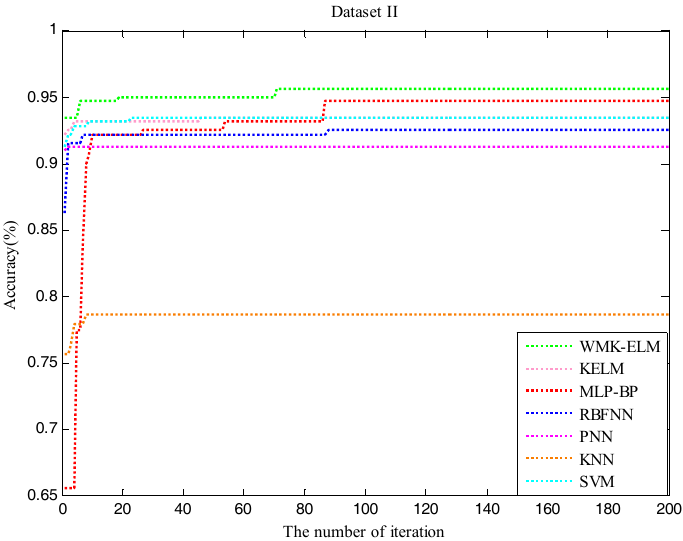
Figure 6. The accuracy of QWMK-ELM and the control classifiers in the process of optimization for Dataset II.